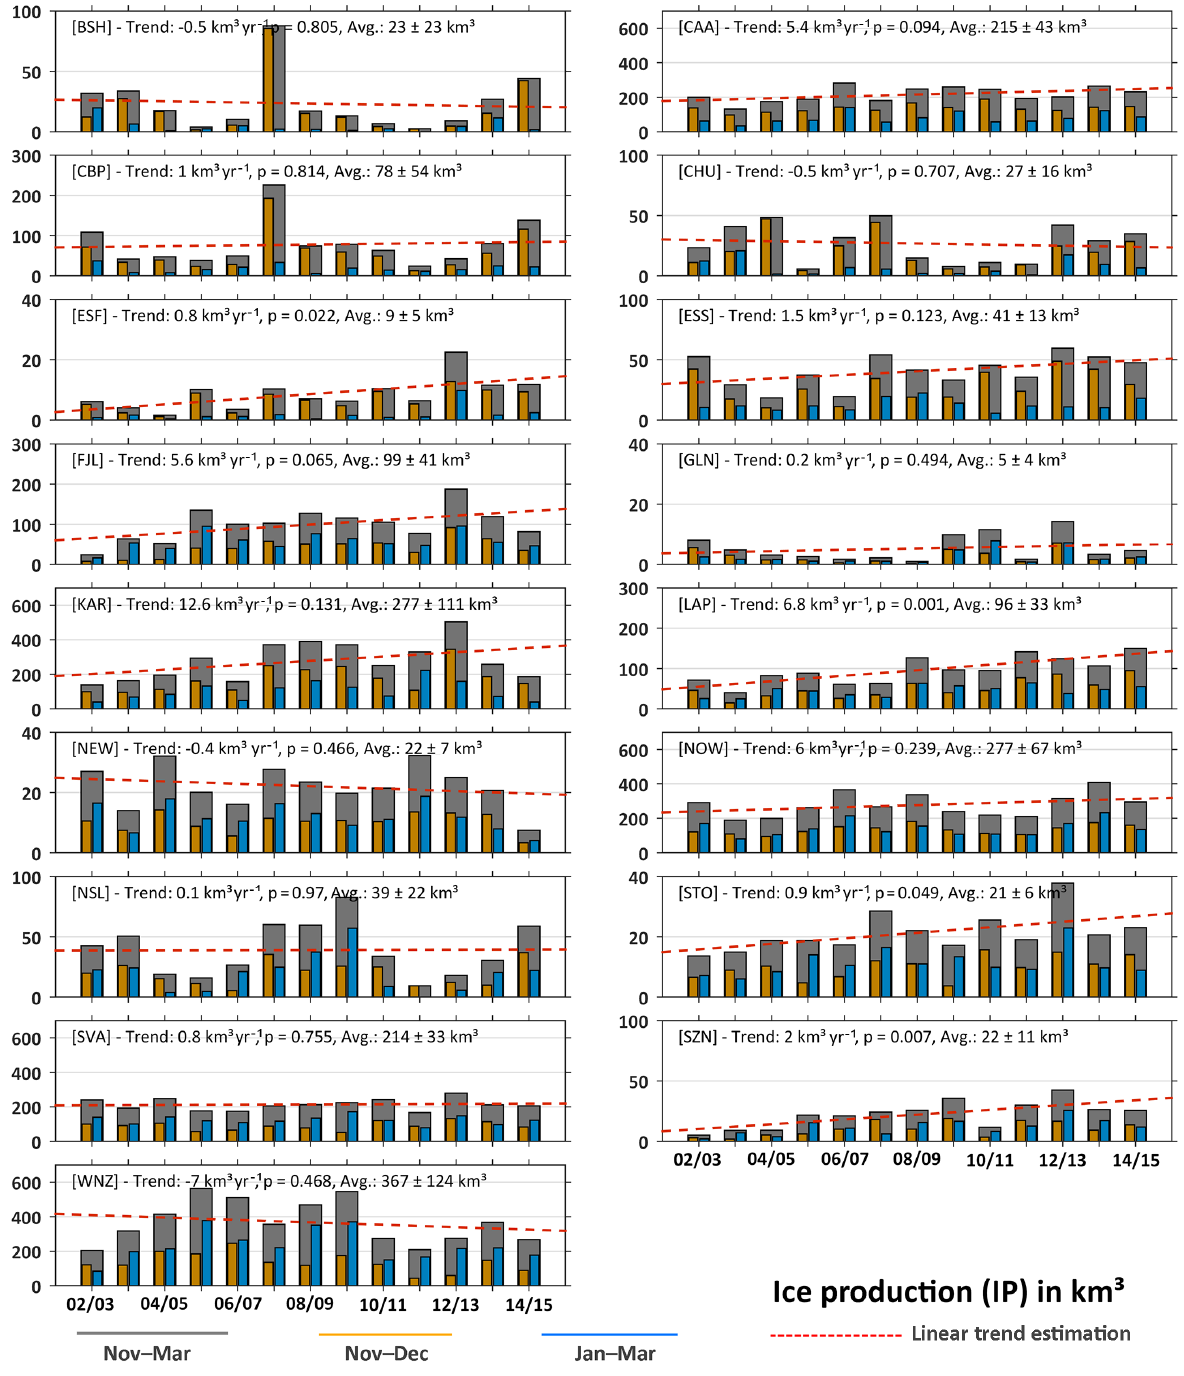
Figure 6. Regional time series of the annually accumulated ice production (IP) in km 3 from 2002/2003 to 2014/2015, together with a seasonal comparison (November to December vs. January to March) and a linear trend estimation. The estimated linear trend (in km 3 yr − 1 ), its p value and the interannual average IP (in km 3 ) are additionally listed in each subpanel. Please note the varying scale on each y